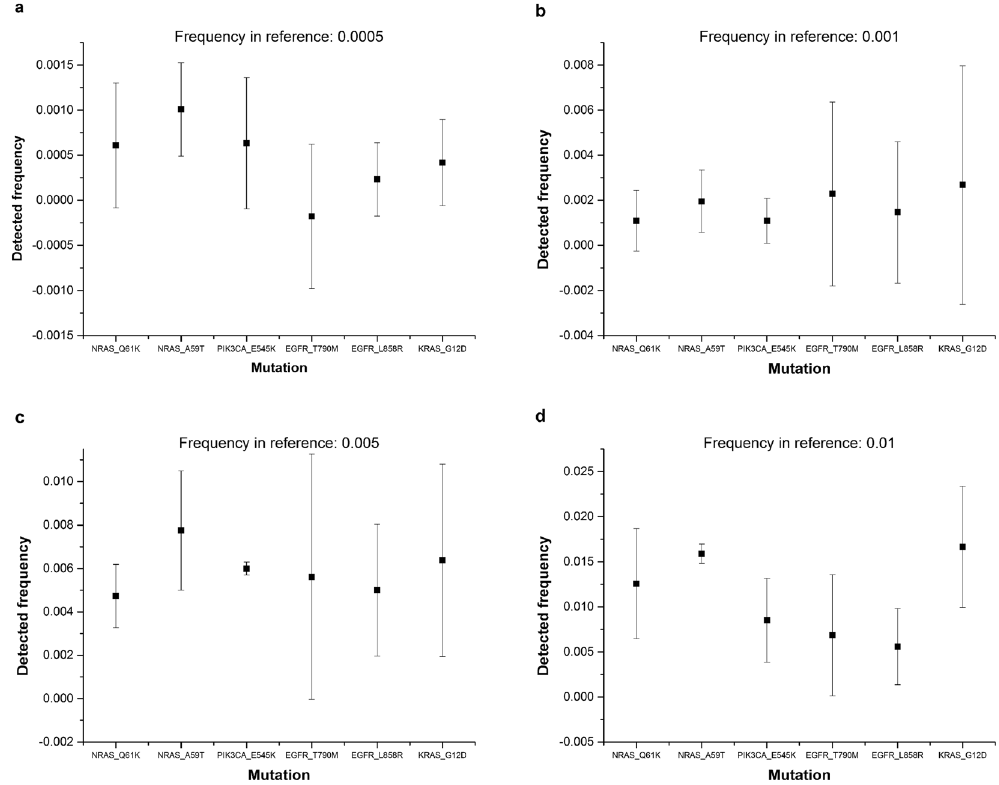
Figure 1. Sensitivity test using Horizon Reference Standard for cfDNA. The reference was manufactured from engineered human cancer cell lines with an allele frequency of 0.0005, 0.001, 0.005, and 0.01. We performed deep sequencing and calculated the allele frequency detected by sequencing in five repeated experiments. Error bars are standard